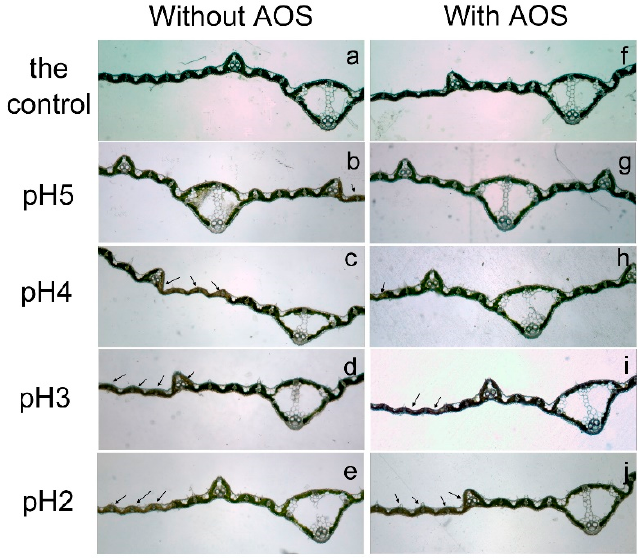
Figure 9. Leaves of rice seedlings exposed to different pH acid rain with and without foliar applying AOS for 7 days. ( a – e ) The leaves subjected to normal temperature treatment. ( f – j ) The leaves subjected to high temperature treatment. ( a , f ) The leaves with the control (pH 7) treatment. ( b , g ) The leaves with pH 5 acid rain treatment. ( c , h ) The leaves with pH 4 acid rain treatment. ( d , i ) The leaves with pH 3 acid rain treatment. ( e , j ) The leaves with pH 2 acid rain treatment.